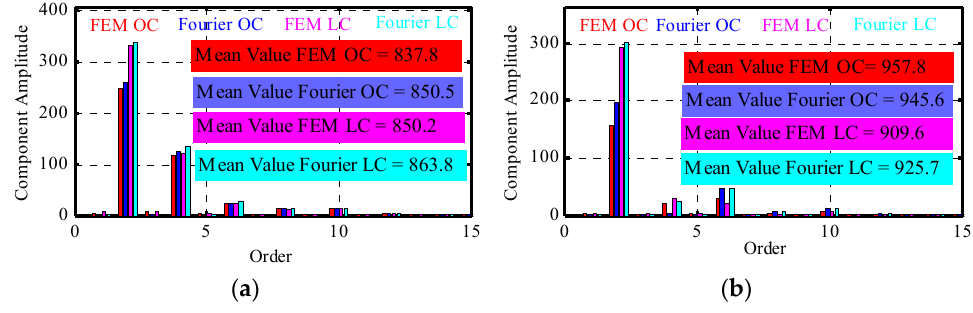
Figure 21. Harmonics of the magnetic forces created on a tooth base: ( a ) Qs48p8, ( b ) Qs36p15.